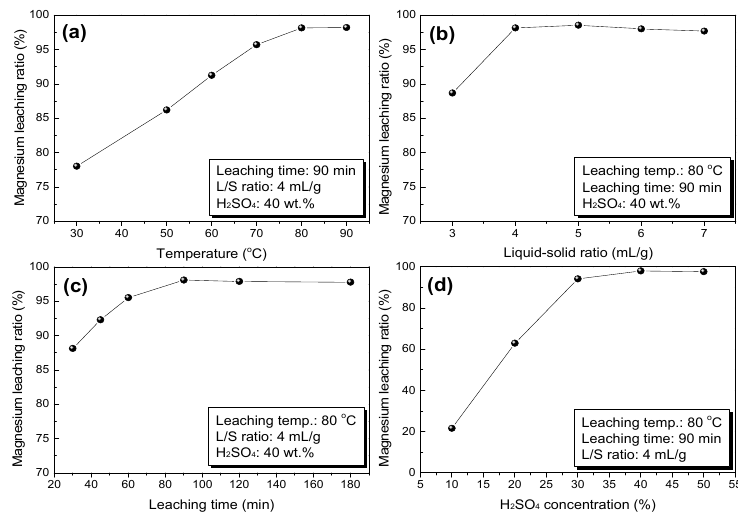
Figure 4. Extraction of magnesium as the function of ( a ) leaching temperature; ( b ) liquid-to-solid ratio; ( c ) leaching time; and ( d ) sulfuric acid concentration.